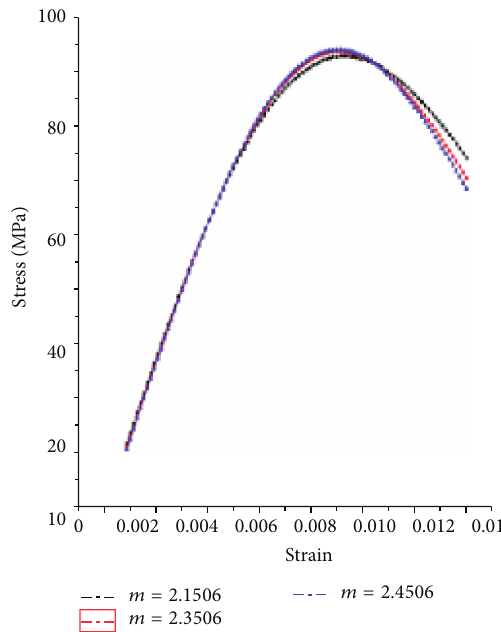
Figure 5: The effect of damage correction factor 𝑞 on constitutive